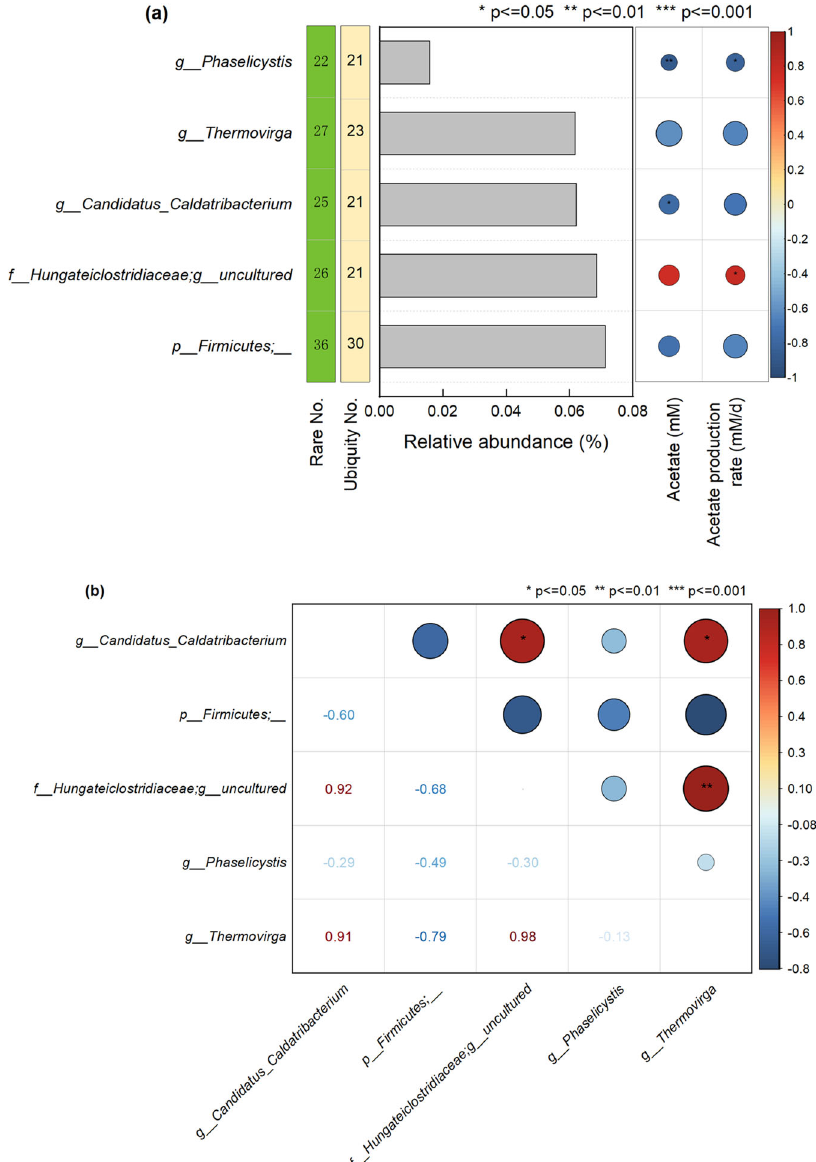
Fig. 3 Characterizations of rare features. a The taxonomic composition of rare features at the genus level and their frequency of abundance (green column), frequency of ubiquity (yellow column), and correlation with acetogenic performance and b Pearson correlation among rare